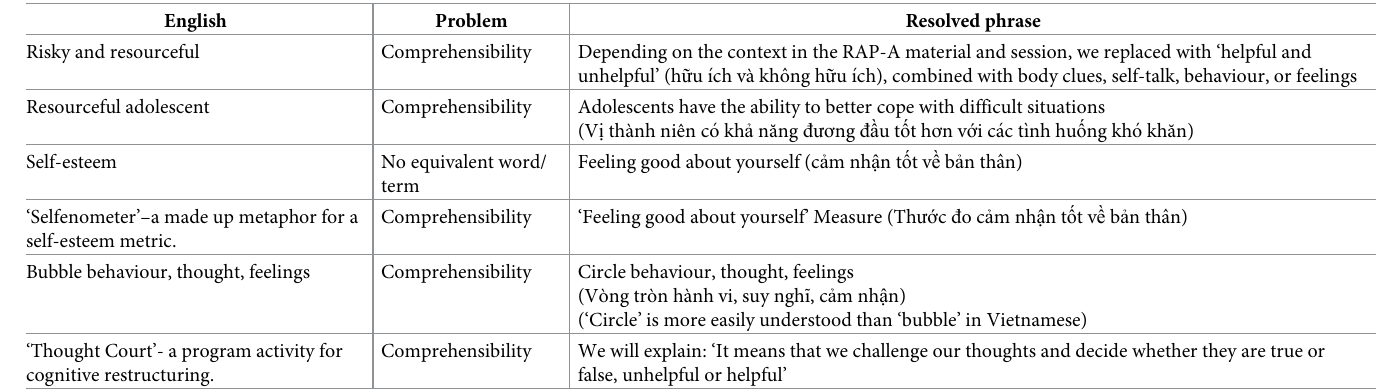
Table 3. Examples of language